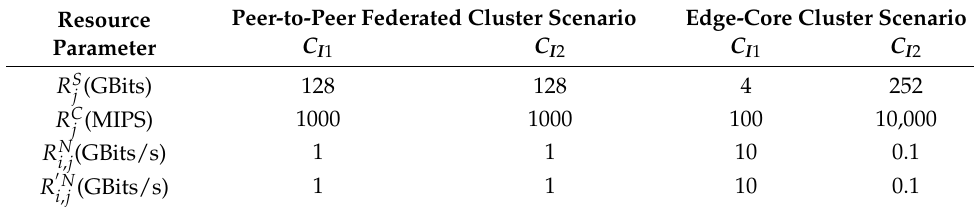
Table 2. Resource parameter settings for test scenarios.